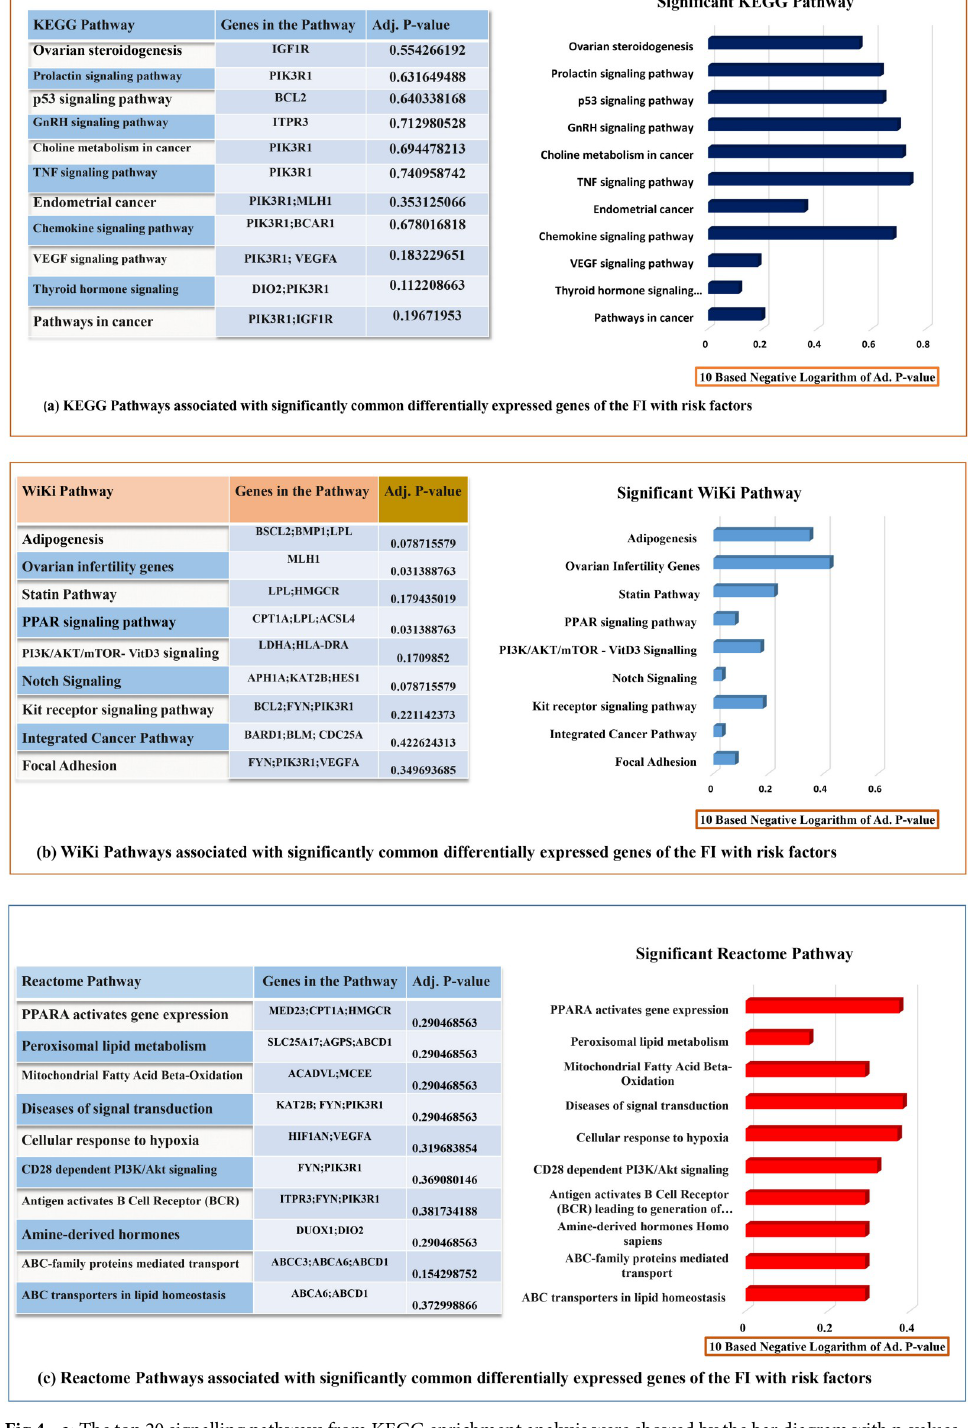
Fig 4. a : The top 20 signalling pathways from KEGG enrichment analysis were showed by the bar diagram with p-values. b : The top 20 signalling pathways from WiKi enrichment analysis were showed by the bar diagram with p-values. c : The top 20 signalling pathways from Reactome enrichment analysis were showed by the bar diagram with